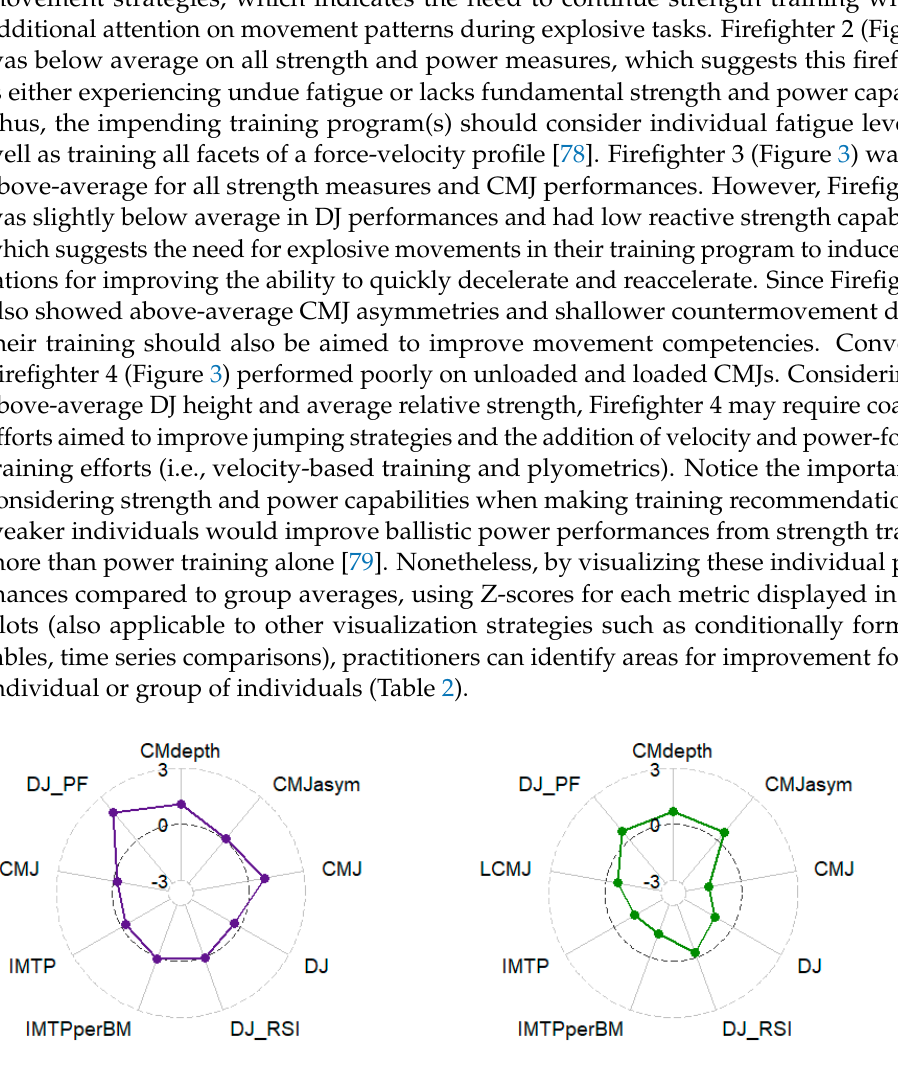
Table 2. Training recommendations based on fitness test performances in Figure 3.